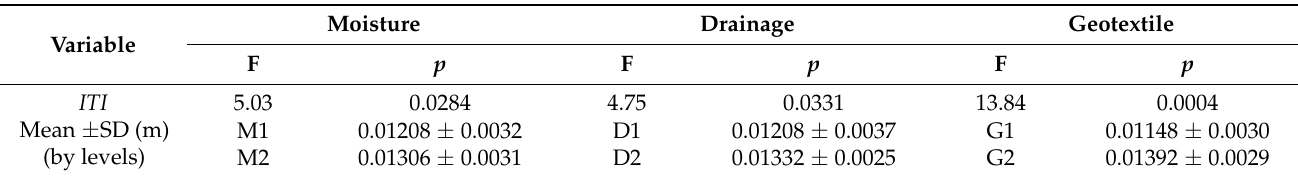
Table 5. Statistic of ITI (f and p -value), mean and standard deviation of ITI to three factors Moisture, Drainage and Geotextile addition.